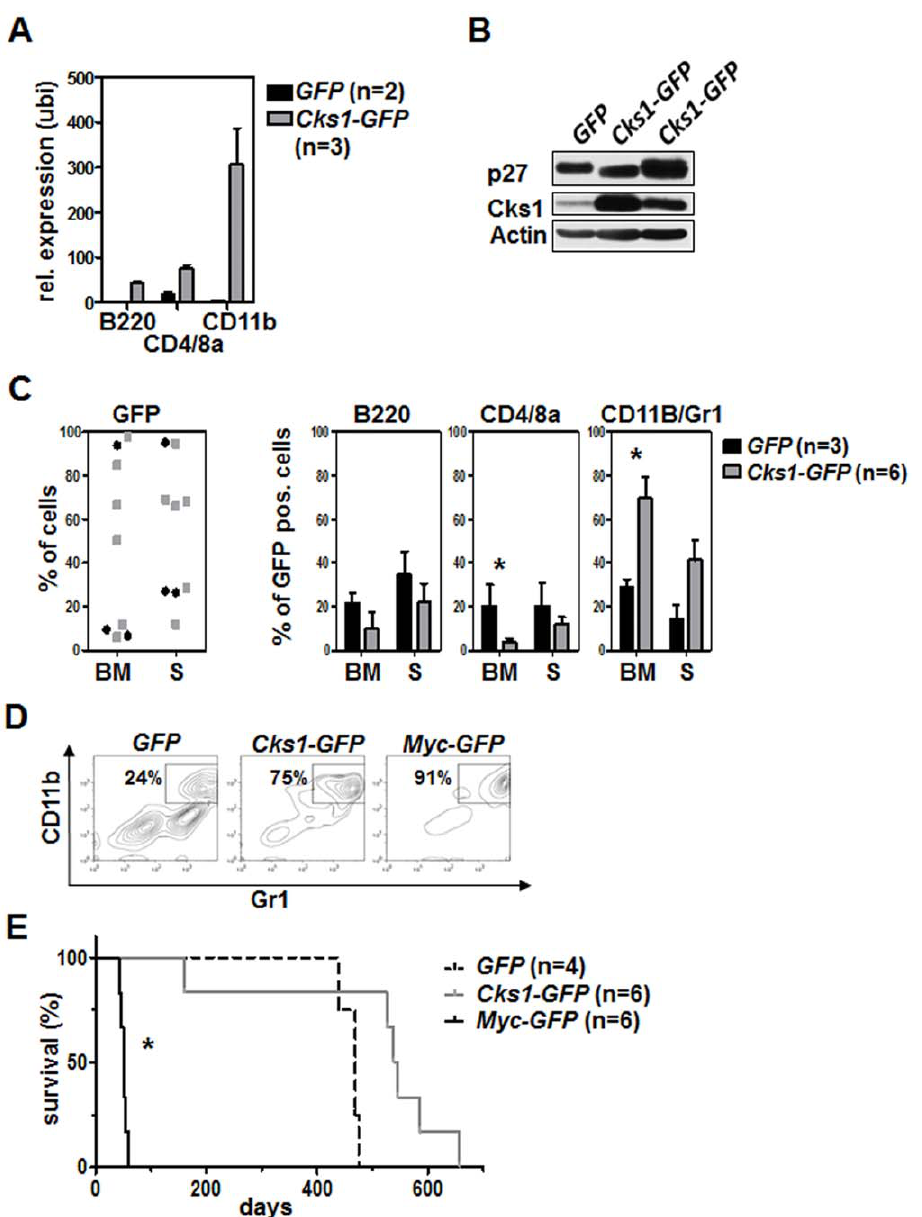
Figure 4. Ubiquitous Cks1 overexpression in the bone marrow is not sufficient to induce myeloproliferative disease or leukemia. 4 6 10 6 GFP-positive cells were transplanted with an infection rate of 30%. A , Cks1 mRNA levels in the indicated bone marrow subsets of transplanted mice were analyzed by realtime PCR at day 160 after transplantation. Shown is the relative expression of Cks1 as compared to the B cell expression of the GFP mice as a control sample set at 1. GFP group: n=2; Cks1-GFP group: n=3. The bars represent the mean relative expression 6 standard deviation. realtime PCR was performed in duplicates. B , Immunoblot analysis of the bone marrow of transplanted mice on the day of indisposition and sacrifice. C , The left panel shows the GFP positivity of the bone marrow (BM) and spleen (S). The three right panels show the percentages of B-, T- and myeloid cells. D , Representative flow cytometric dot blot images of the myeloid cell compartment of GFP , Cks1-GFP and Myc-GFP animals on the day of their sacrifice. E , Survival analysis of lethally irradiated recipient mice that were transplanted with GFP , Cks1-GFP or Myc-GFP infected bone marrow. None of the GFP or Cks1-GFP mice died of leukemia, while all Myc-GFP mice succumbed to AML. Median survival: GFP group, 469 days; Cks1- GFP group, 541.5 days; Myc-GFP group, 52 days. Only the survival of Myc-GFP group is significantly different from the other